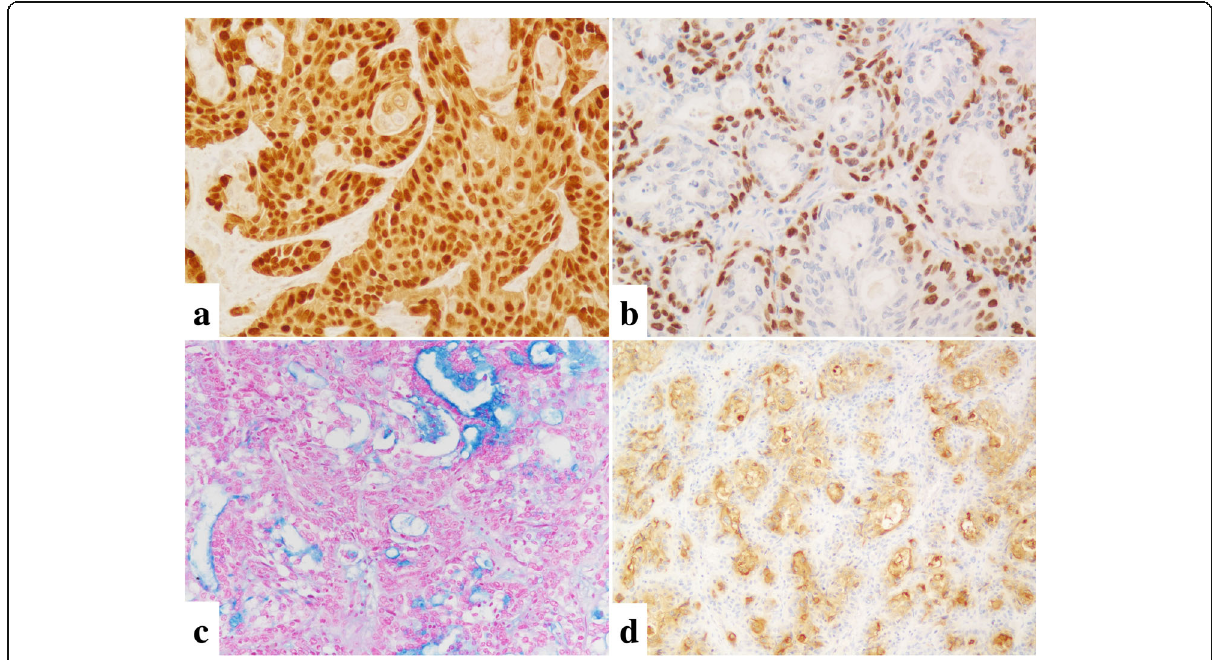
Fig. 2 a : Squamoid and intermediate cells were positive for both p63 (nucleus) and CK14 (cytoplasm) by double immunostaining of p63 and CK14 (× 200). b: Mucin-producing cells were negative for p63 (× 200). c: Alcian blue staining highlights the mucin of mucin-producing cells (× 200). d: Tumor cells focally positive for CEA (×